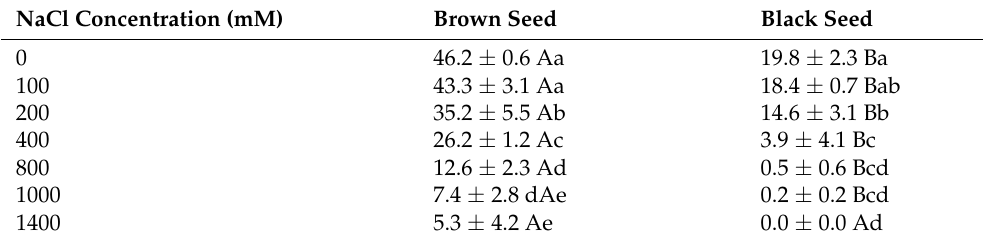
Table 2. Germination index of dimorphic seeds from S. liaotungensis under different NaCl concentrations. NaCl Concentration